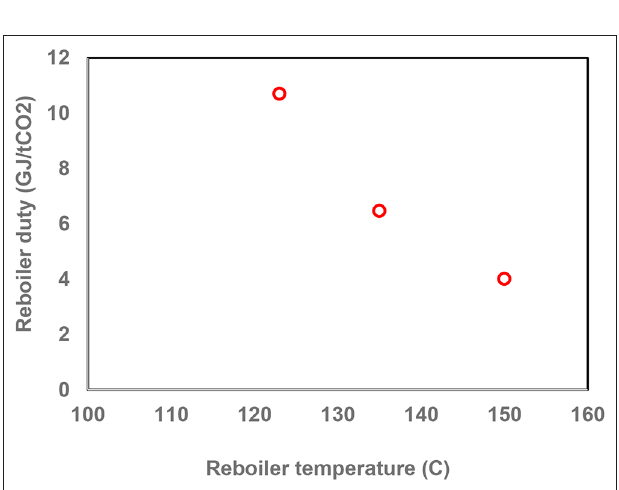
FIGURE 6 | Reboiler duty at different reboiler